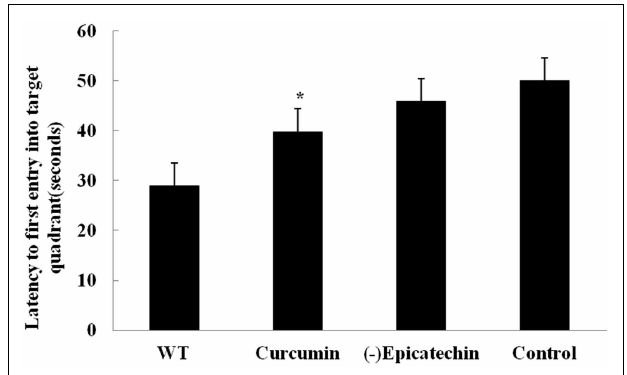
FIGURE 2 | Effect of ( − )epicatechin on learning and memory in APP/PS1 transgenic mice after treated 9months, Mice were trained for 7day in Morriz water maze . On the 8day performed a probe test, and the time to enter the correct quadrant where the platform had been was measured. One-way ANOVA with Student–Newman–Keuls post hoc corrections in this graph, no differences ( P > 0.05). Bars represent mean ± SEM. Statistical software package was SPSS17.0.